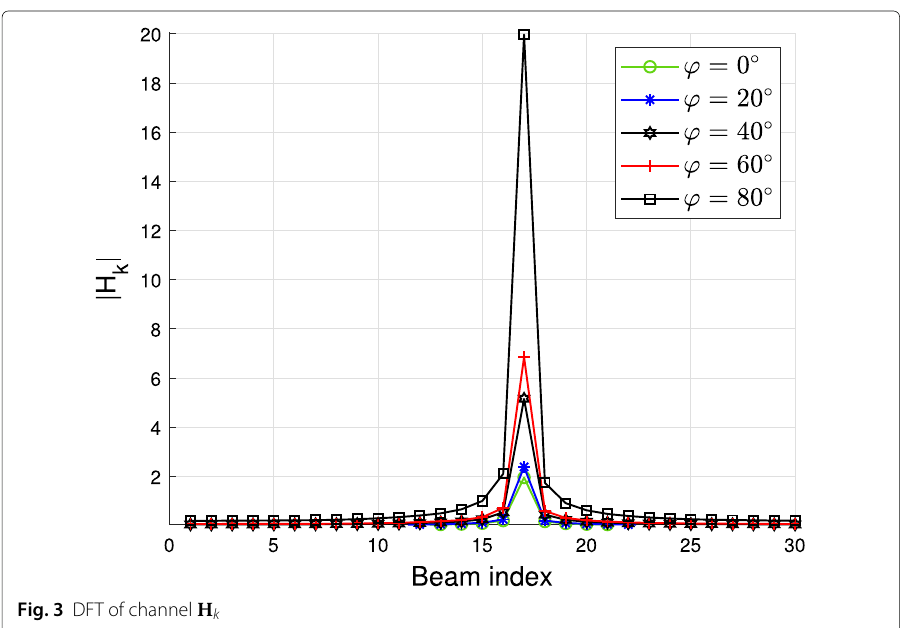
Fig. 3 DFT of channel H